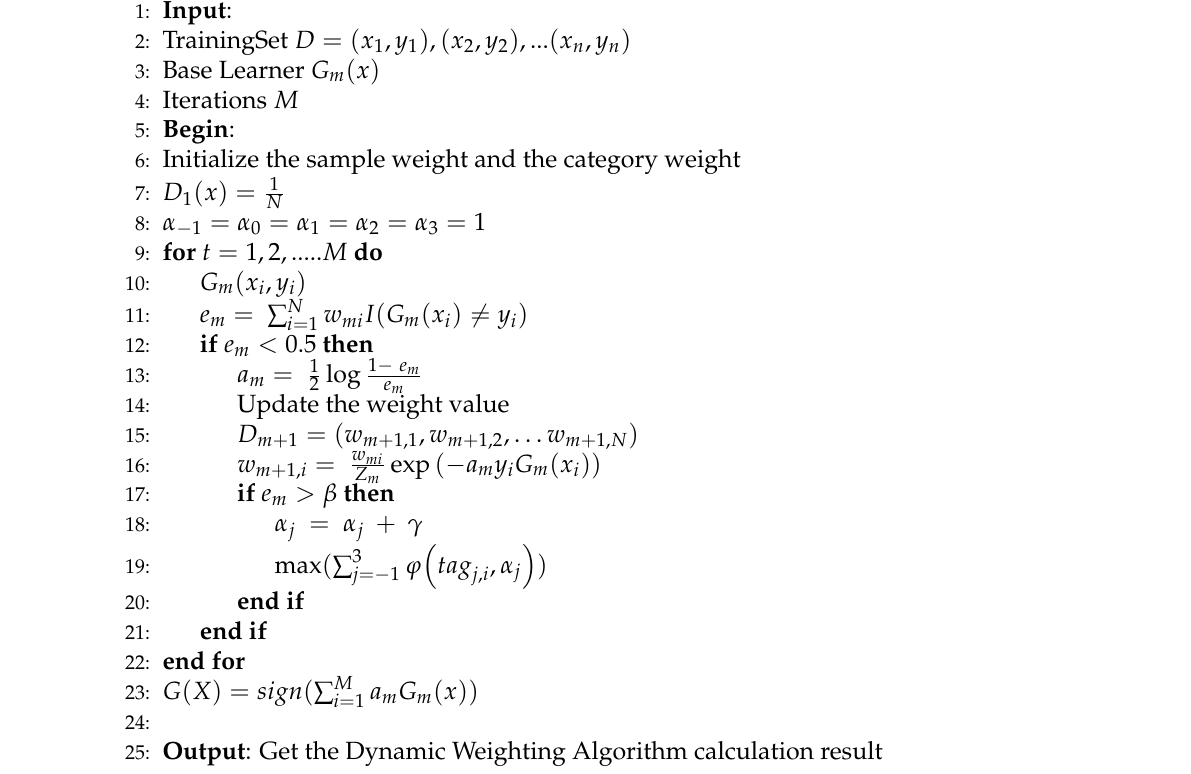
Algorithm 1 The Dynamic Weighting Algorithm